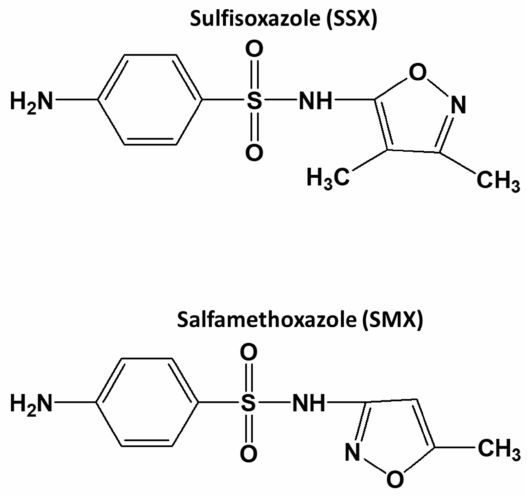
Figure 1. Molecular structures of SSX and